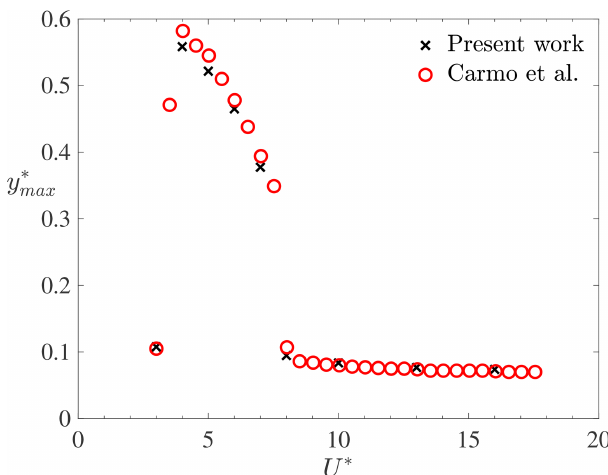
Figure 4. Non-dimensional maximum motion amplitude as a func- tion of the reduced velocity for Re = 150, m ∗ = 2, and ζ = 0 .